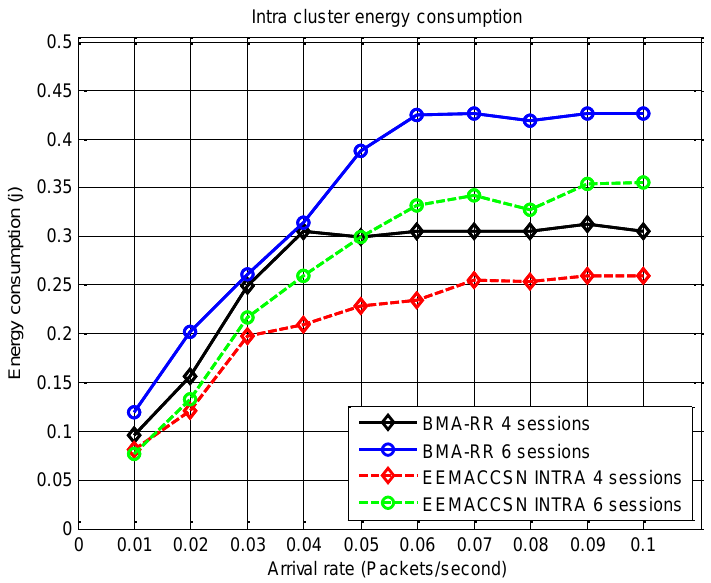
Figure 9. Intra-cluster energy consumption per node vs. arrival rate.